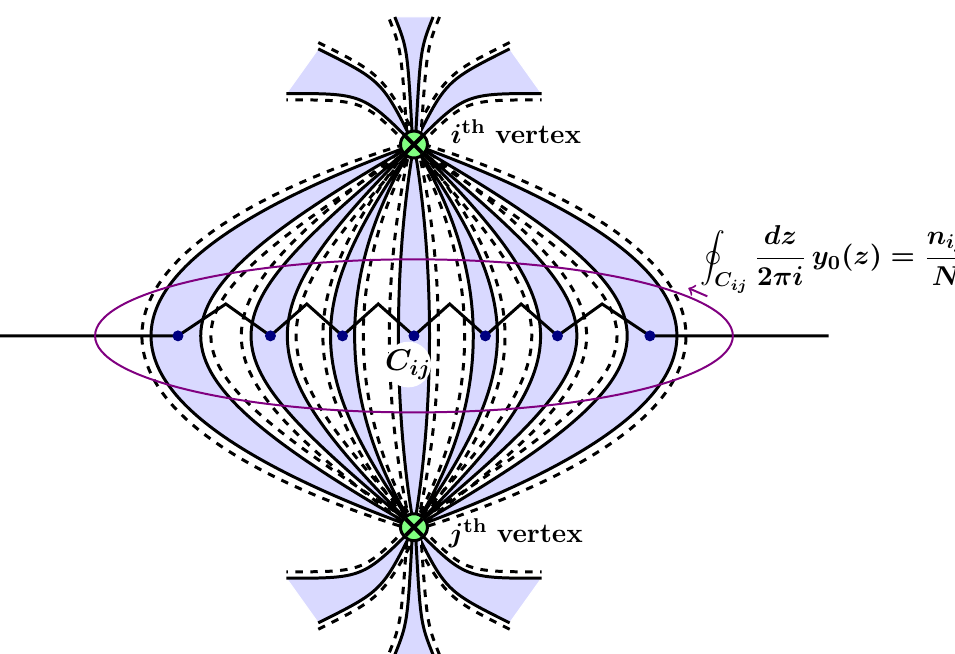
Figure 4 . The period integral along the cut that corresponds to the dual edge d ( ij )